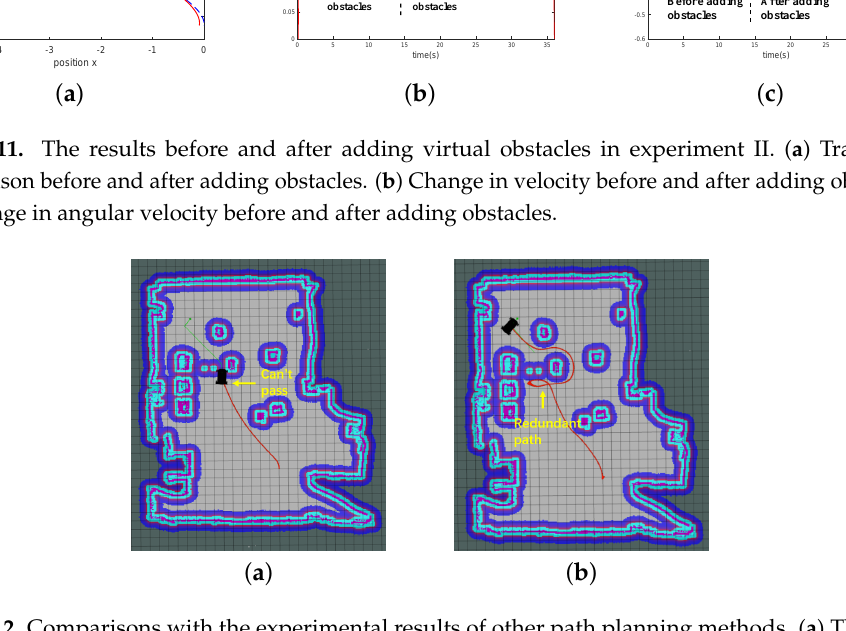
Figure 12. Comparisons with the experimental results of other path planning methods. ( a ) The path planning effect using the DWA method. ( b ) The path planning effect using the traditional VFH*